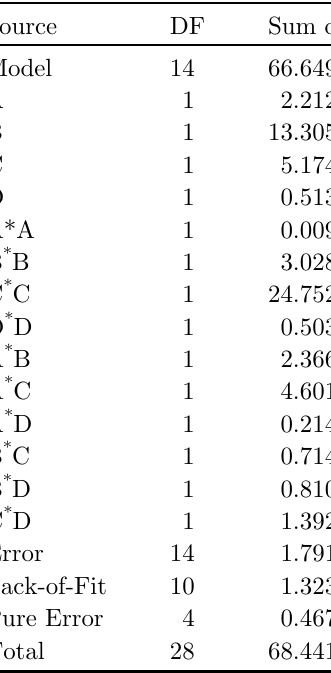
Table 4. Initial ANOVA for fatigue